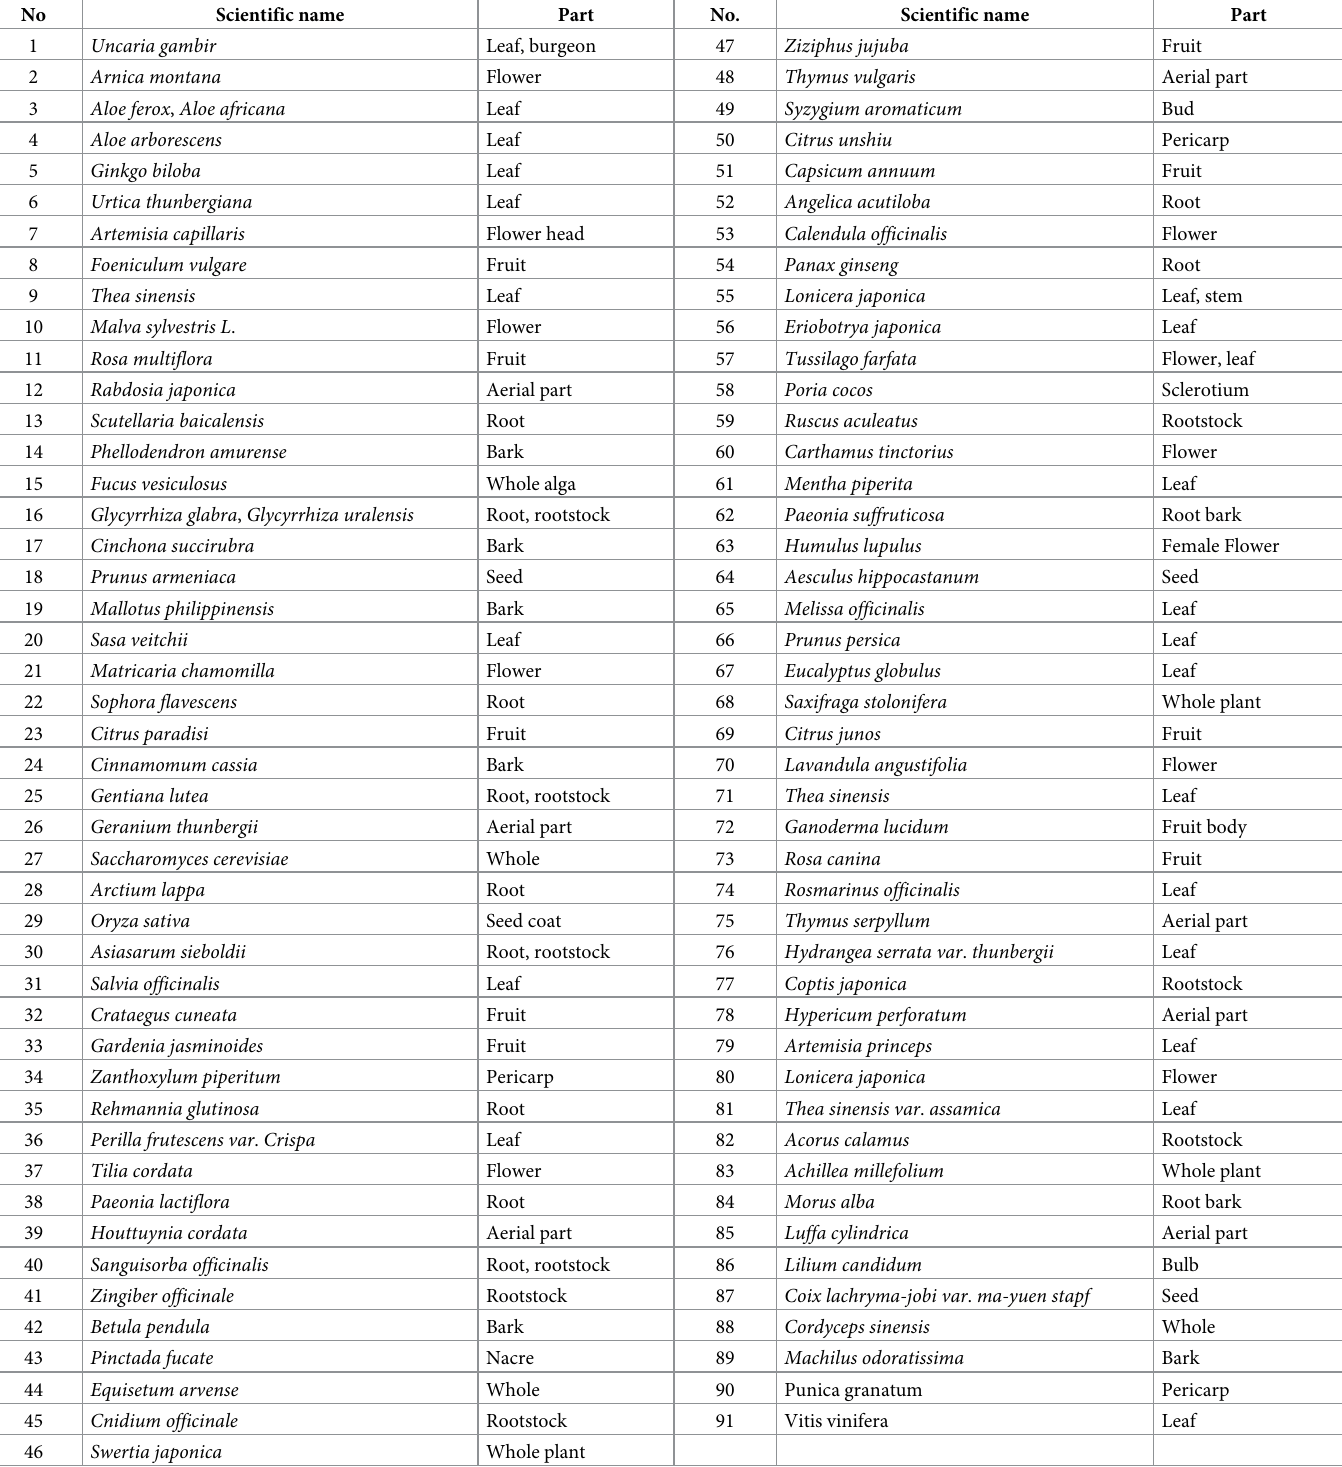
Table 1. A list of herbal plants used in screening of Sema3A